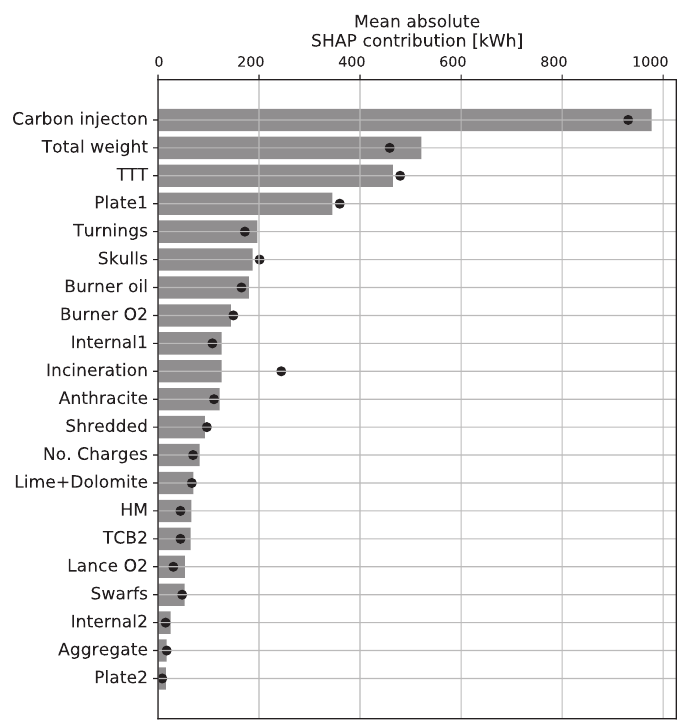
Figure 12. SHAP feature importance for the selected model as defined in Equation (15). The bars show the feature importance on the training data and the dark dots show the feature importance on the test data. Table 9. Correlation between the input variables and the EE consumption as defined in the transformer system. The input variables are ordered by dCor in the training data set. The values in parentheses are the Pearson correlation